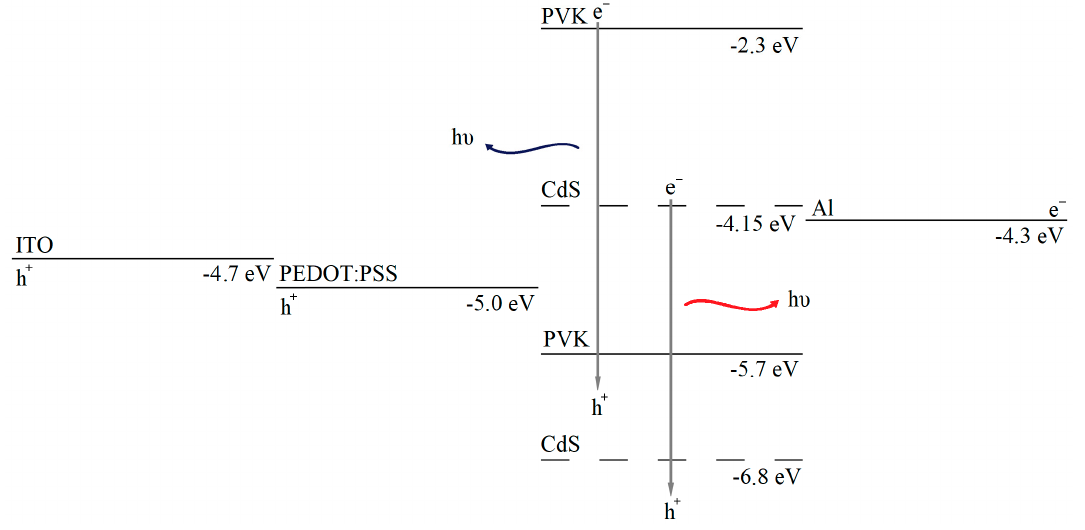
/ PEDOT:PSS / PVK:CdS / Al